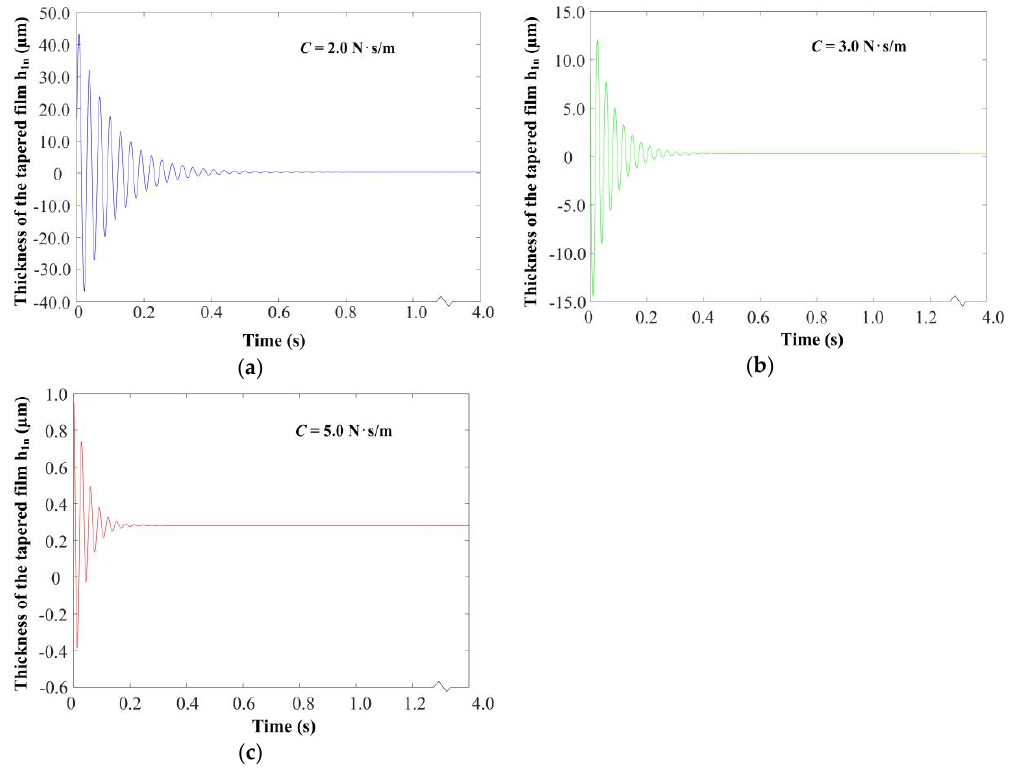
Figure 15. ( a ) Thickness of the tapered film over time ( C = 2.0 N∙s/m); ( b ) thickness of the tapered film over time( C = 3.0 N∙s/m); ( c ) thickness of the tapered film over time for h 1n ( C = 5.0 N∙s/m).